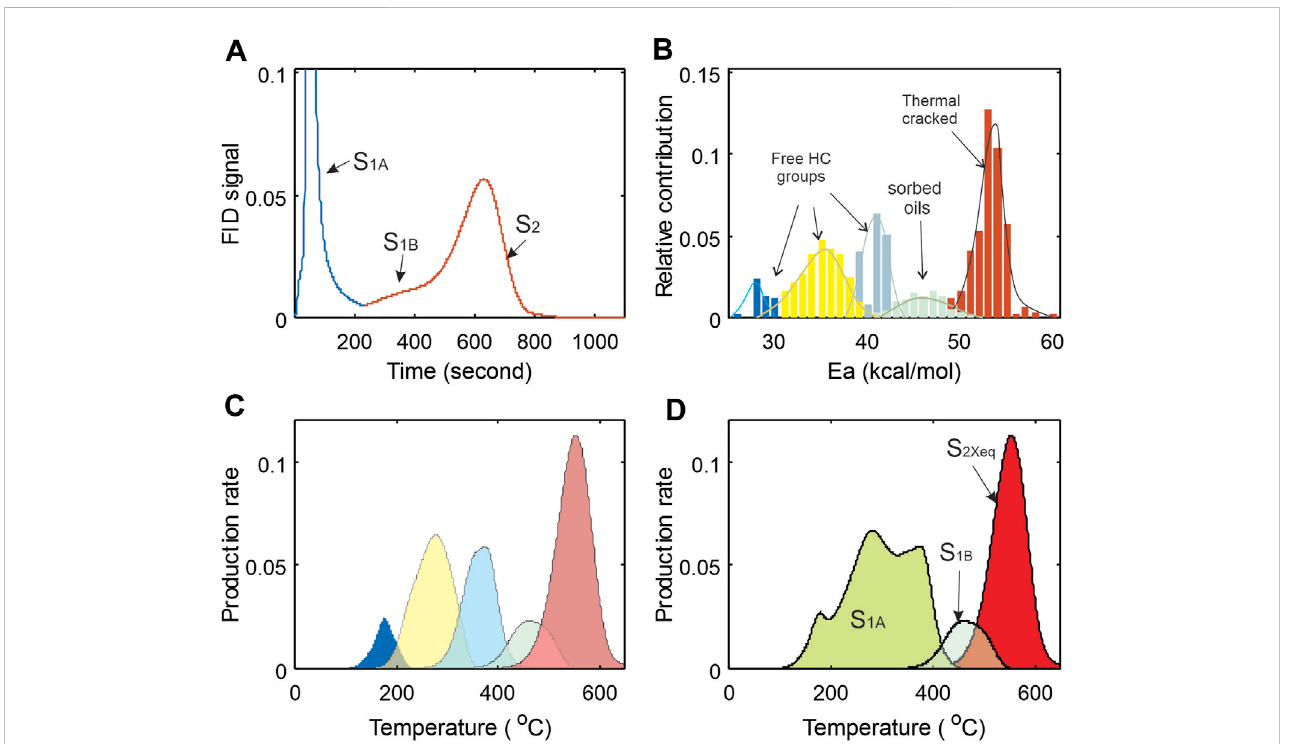
FIGURE 3 Thematic diagrams showing partition of Rock-Eval FID pyrogram and corresponding activation energy groups and thermal production make-ups. FID responses of petroleum products from pyrolysis can be plotted in different variable spaces: (A) FID response vs. time of thermal analysis (FID curve); (B) decomposed FID in activation energy space; (C) thermal products re-grouped in temperature domain that were converted from (B) ; and (D) three categories ofproductsre-groupedfrom (C) andde fi nedin (A) intemperaturedomain. (B) and (C) aremathematicprojectionsof (A) inEaandTvariablespaces,while (D) is re-grouped (C)